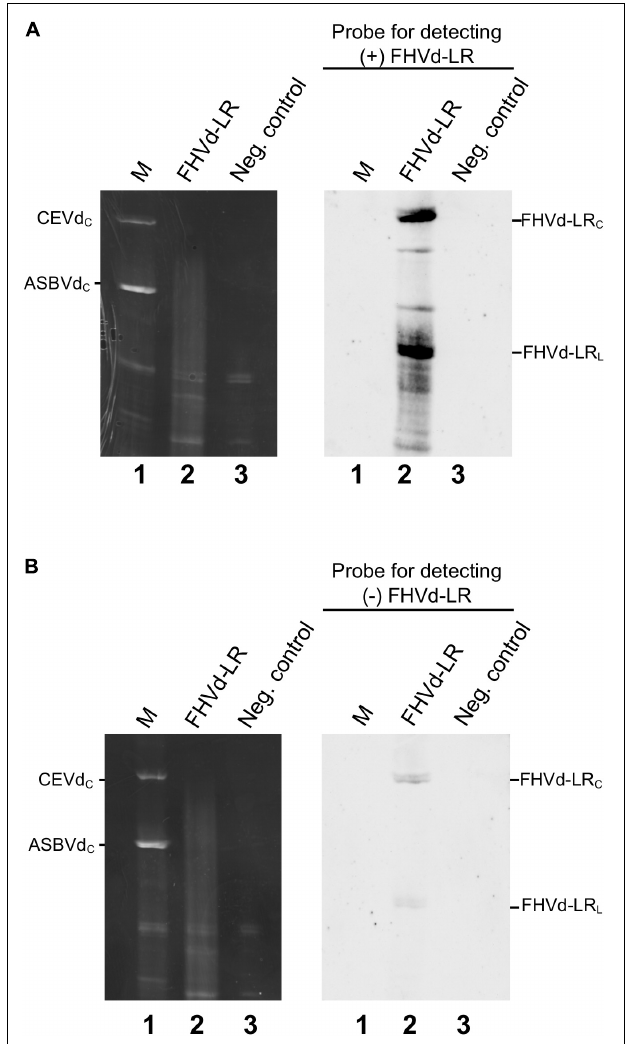
FIGURE 4 | Northern blot hybridization assays to detect circular RNAs and identify the most abundant FHVd-LR strand denoted ( + ) polarity strand. Fig RNA preparations separated by double PAGE (left) were transferred to nylon membranes and hybridized with equalized full-length digoxigenin-labeled riboprobes for detecting the ( + ) and ( − ) FHVd-LR strands (A,B) , respectively. The second (denaturing) gel of the double PAGE, stained with ethidium bromide, and the northern blot results are respectively reported on the left and on the right of each panel. Lane 1 corresponds to RNA preparations from Gynura aurantiaca and avocado infected by citrus exocortis viroid (CEVd, 371 nt) and avocado sunblotch viroid (ASBVd, 246 nt) respectively, used as molecular markers (M); lane 2 is an RNA preparation from a fig tree that tested positive to FHVd-LR by RT-PCR assay; lane 3 is an RNA preparation from FHVd-LR fig tree that tested negative to FHVd-LR and used as negative control. Identical aliquots of the same RNA preparations were loaded in the gels shown in panels (A,B) . The positions of circular forms of CEVd and ASBVd (CEVdc and ASBVdc), visible in the gel stained with ethidium bromide, are reported on the left; the positions of circular and linear forms of FHVd-LR detected by the specific probes for the ( + ) and ( − ) polarity strands [panels (A,B) , respectively] are indicated on the right. Bands between the circular and linear forms could correspond to artifacts generated by UV-induced cross-links during the visualization of the first non-denaturing gel of the double PAGE, as observed previously for some viroids (Hernández et al., 2006; Serra et al.,